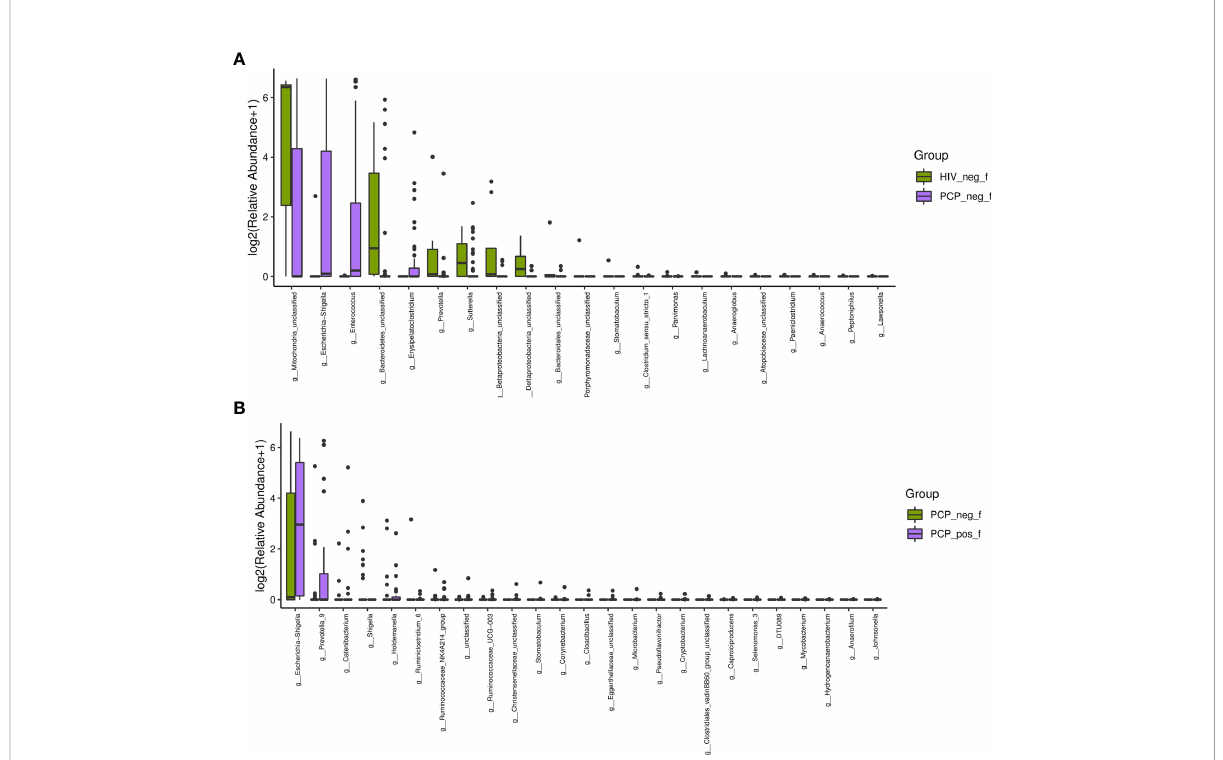
FIGURE 6 Characteristics of the gut microbiota composition among HIV+PCP+ group (PCP_pos_f), HIV+PCP- group (PCP_neg_f), and HIV- group (HIV_neg_f) at the genus level. (A) The differential genera are shown between HIV+PCP- and HIV- patients. (B) The differential genera are shown between HIV+PCP+ and HIV+PCP-